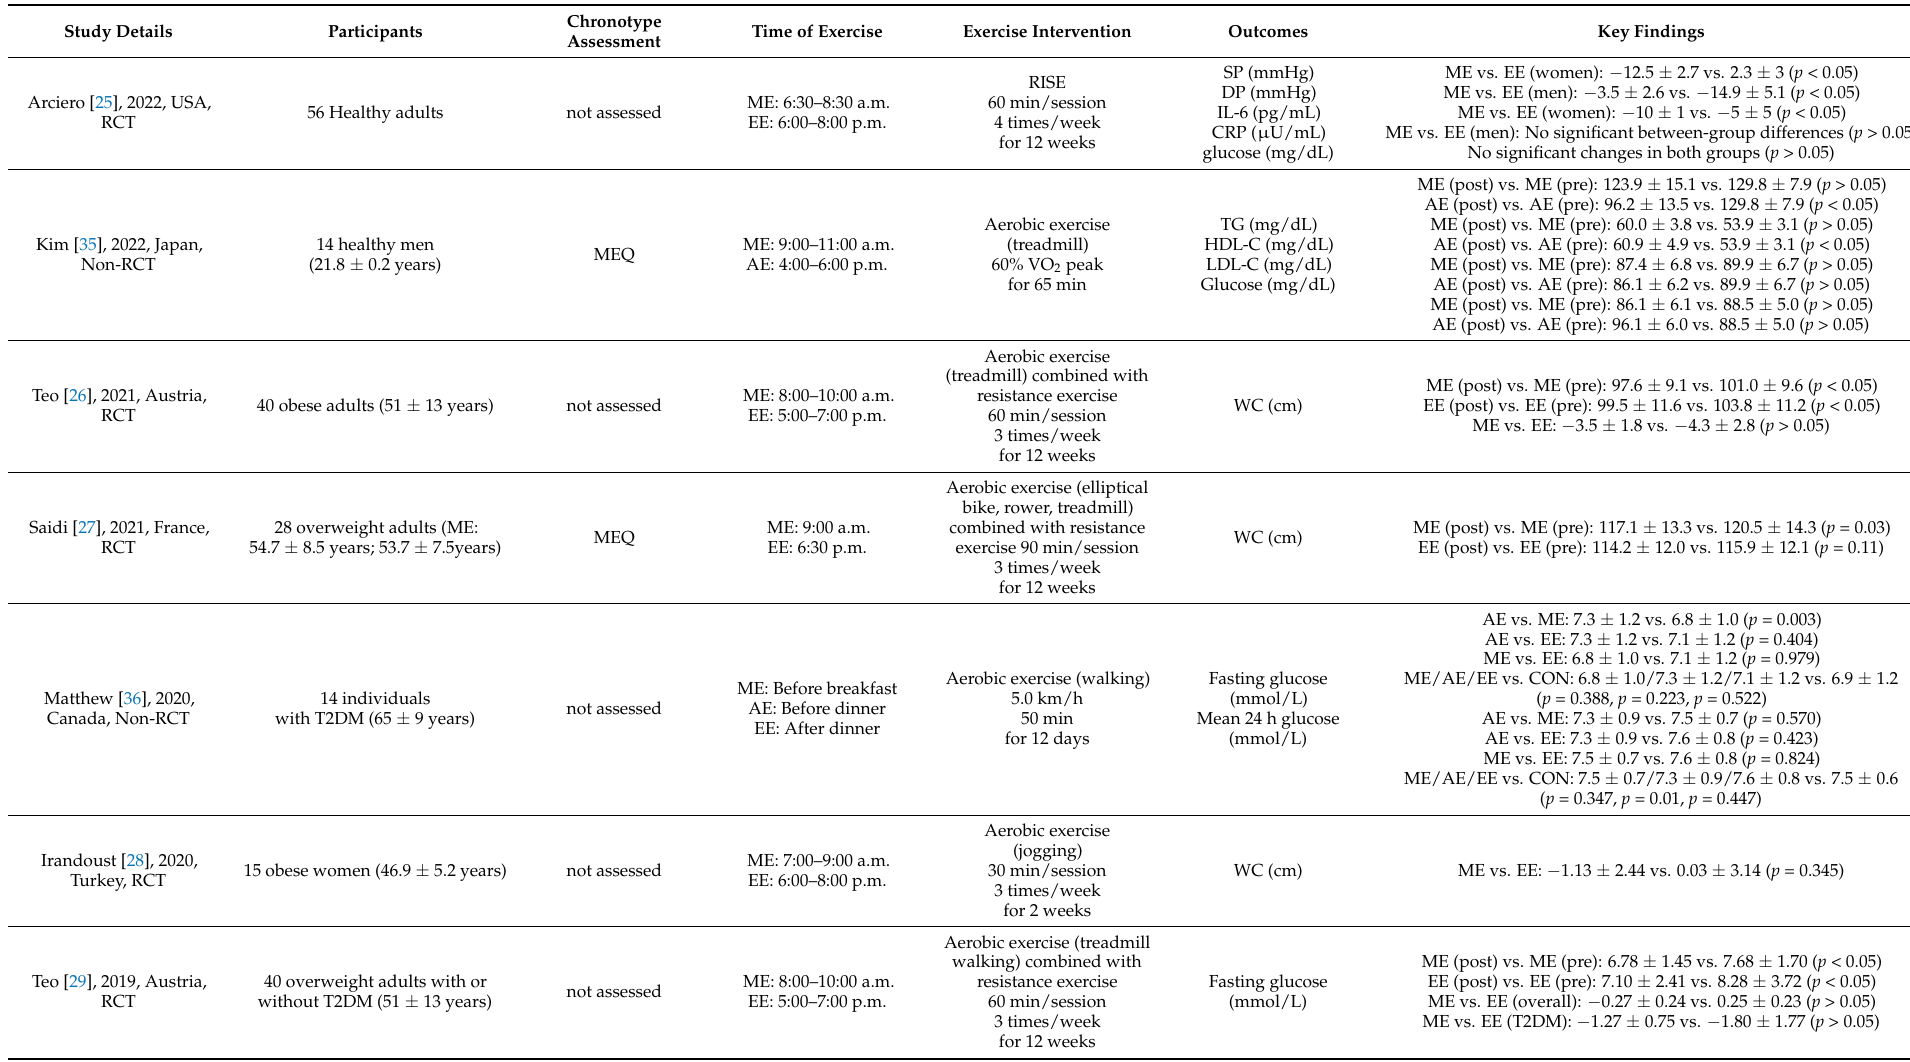
Table 1. Time-dependent effects of physical activity on cardiovascular risk factors in